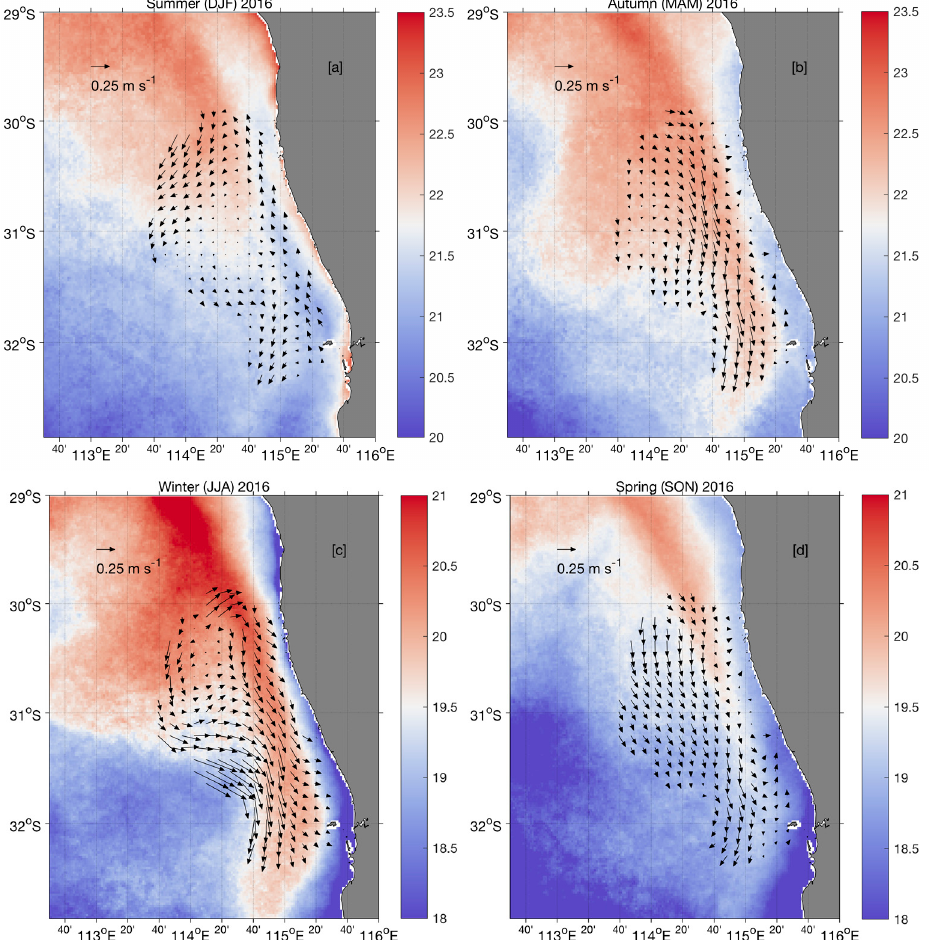
Figure 5. Seasonally-averaged HFR and SST data for 2016: ( a ) Summer (DJF); ( b ) Autumn (MAM); ( c ) Winter (JJA); ( d ) Spring (SON). Note changes in SST scale for summer / autumn ( a , b ) and winter / spring ( c , d ). Vector data have been subsampled every two grid point to increase readability. SST data originated from multi-sensor L3S foundation SST product.